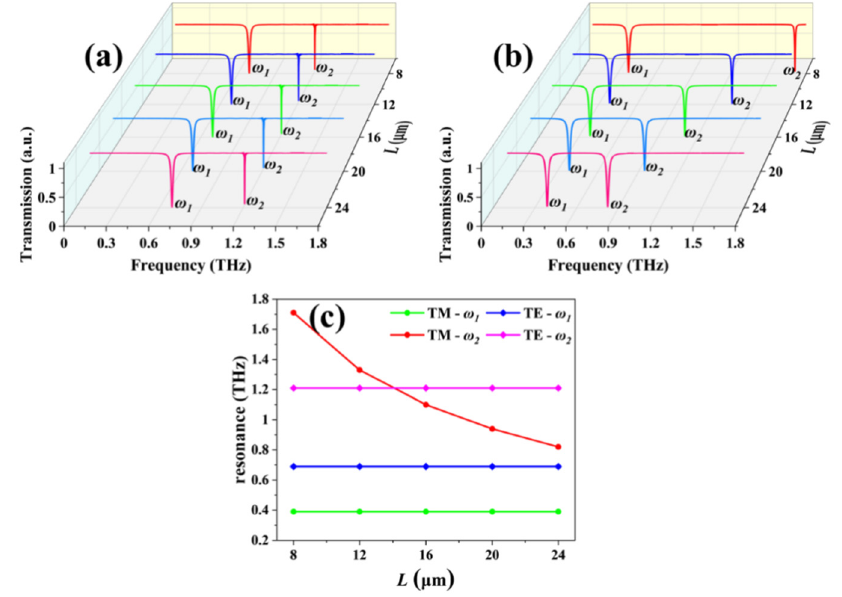
Figure 5. Transmission spectra of eSRR with different L ( L = L 1 = L 2 ) values in ( a ) TE and ( b ) TM modes. ( c ) The relationships of resonances and L values in ( a , b ).